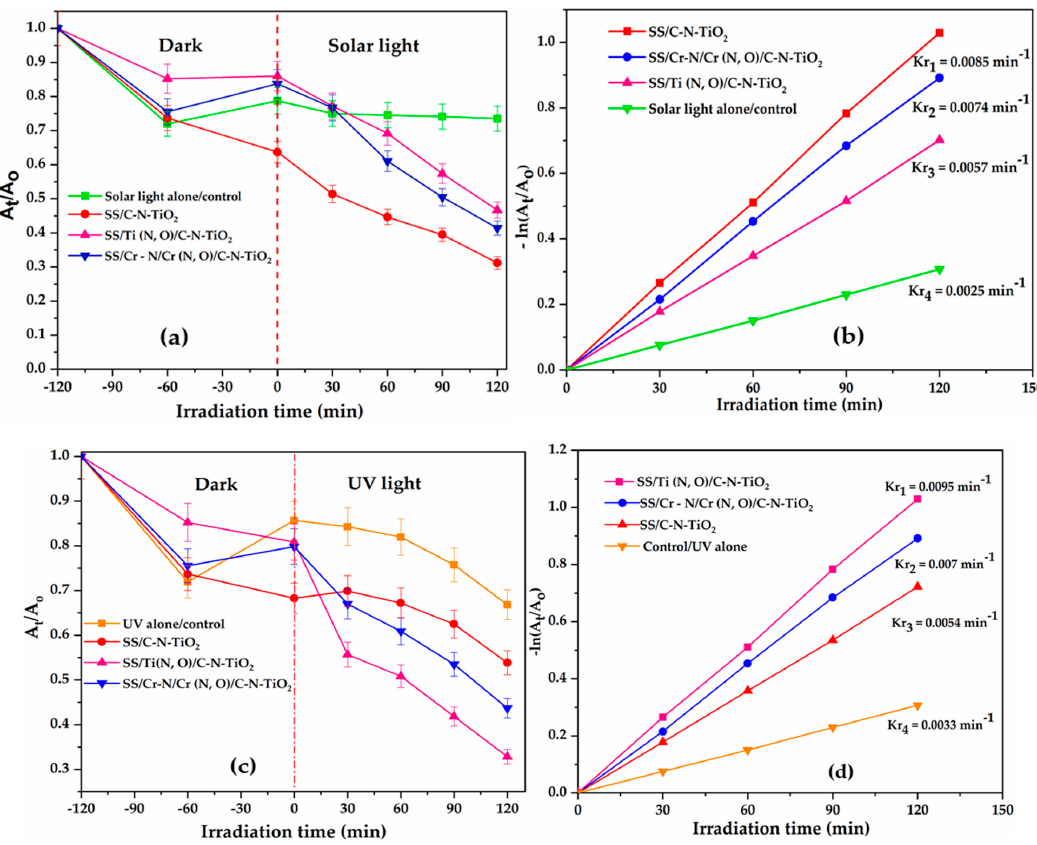
Figure 7. Kinetics trends of the photocatalytic decomposition of O.II dye under solar light ( a , b ) and UV light ( c , d ) by SS and anticorrosion meshes coated with C-N-TiO 2 catalysts. Experimental conditions: [O.II] 5 mg / L, pH 2.5, volume 500 mL, Mega-Ray 160 W / 240 V MR160 UV lamp, and an irradiation time of 120 min ( n = 3). Table 3. Kinetic parameters for the decolouration of orange II dye at the following conditions: [O.II]